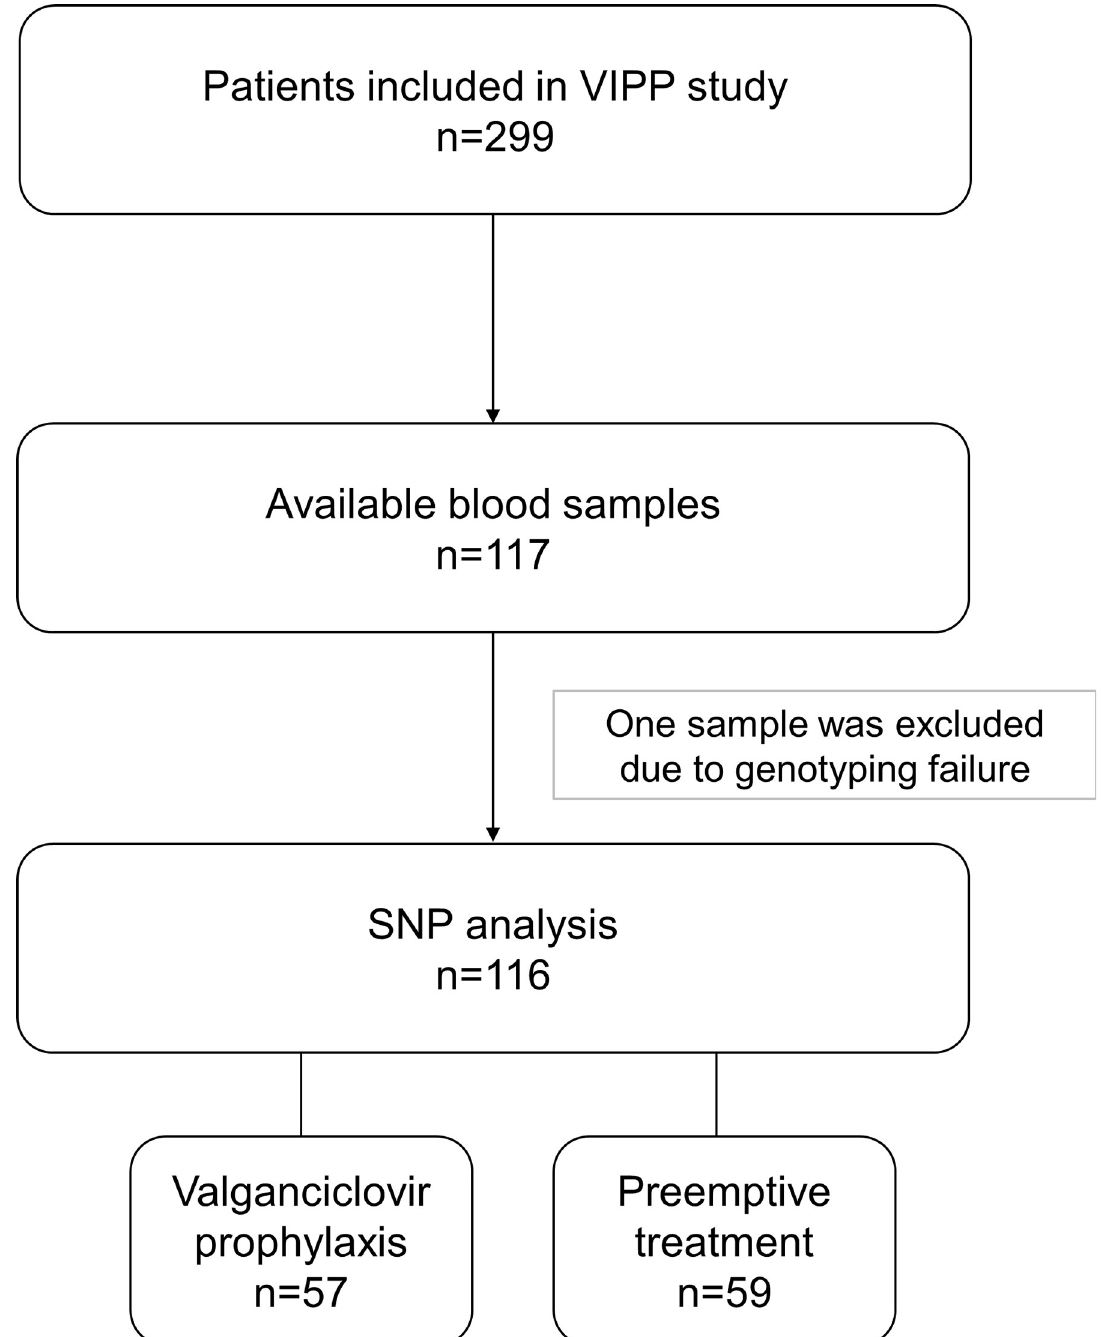
Fig 1. Disposition of patients and samples analyzed. SNP, single nucleotide polymorphism; VIPP, ValgancIclovir Prophylaxis versus Preemptive therapy in cytomegalovirus-positive renal allograft recipients.